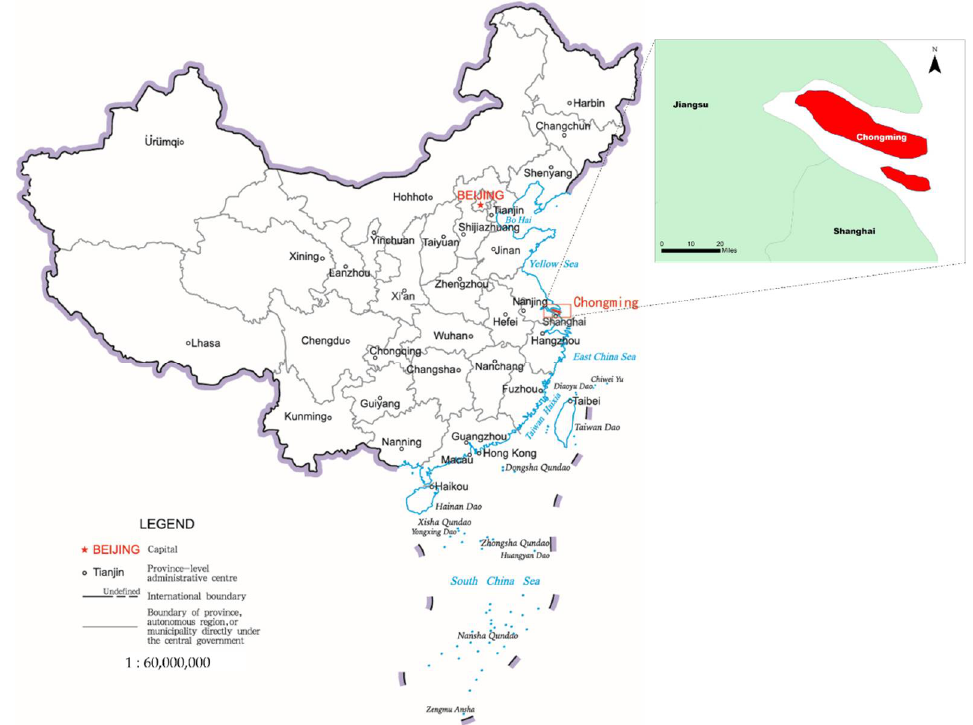
Figure 3. The location overview of the research area.